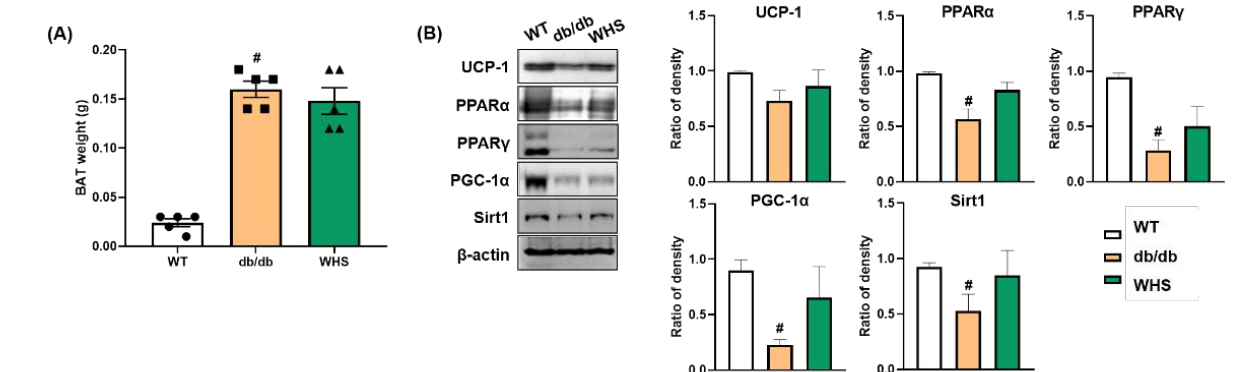
Figure 6. Effect of WHS on thermogenic factors in the BAT of db/db mice. ( A ) Brown adipose tissue (BAT) weight. ( B ) Total protein was extracted from BAT and western blot analysis was performed to examine the expression of UCP-1, PPAR α , PPAR γ , PGC-1 α , and SIRT-1. Values are expressed as the mean ± SEM. # p < 0.05 vs. WT control group.